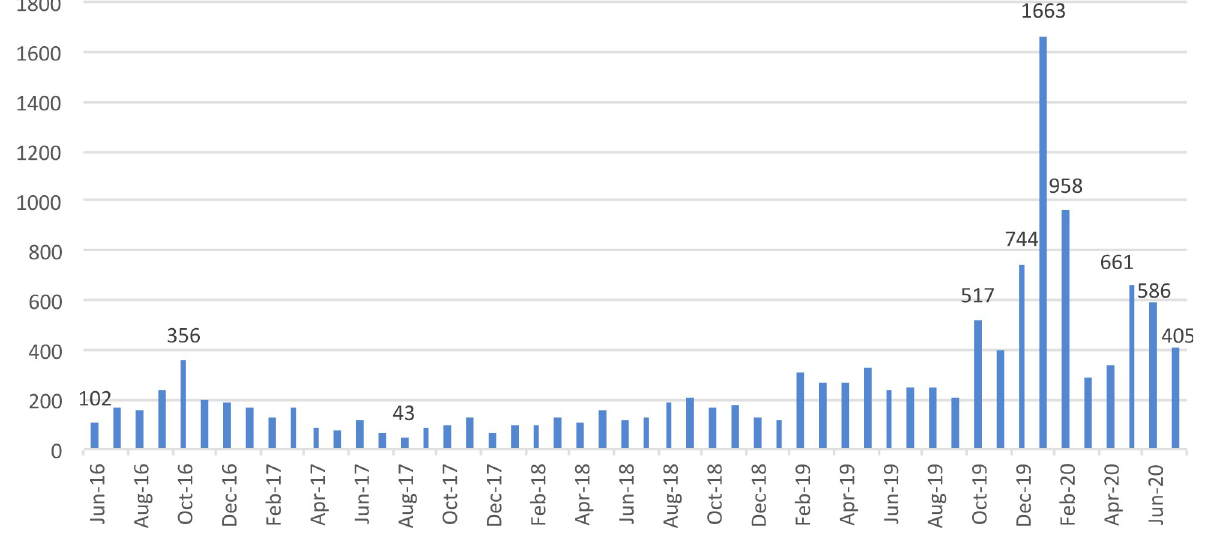
Fig 3. Number of consultations for clinical scabies reported by centers hosting refugees/asylum seekers, per month.